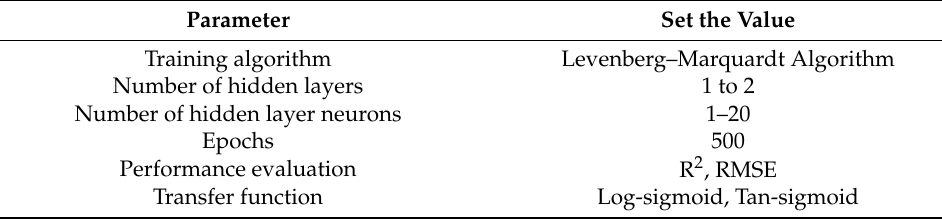
Table 7. Back propagation neural network (BPNN) model training parameters.